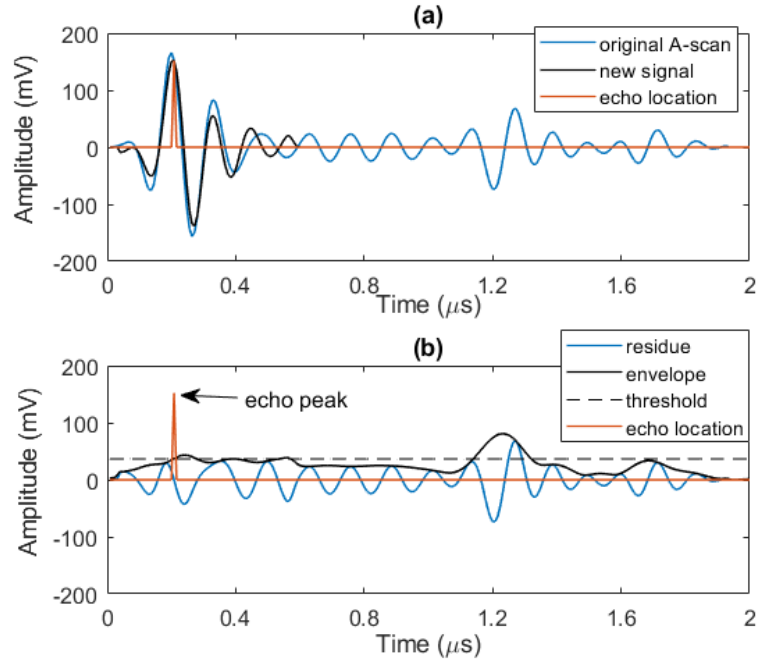
Figure 9. ( a ) Original A-scan and its approximate (new signal) after the 1st step of performing echo localization, ( b ) residue of the 1st step and its envelope that feeds back to the algorithm for next step, and the peak echo